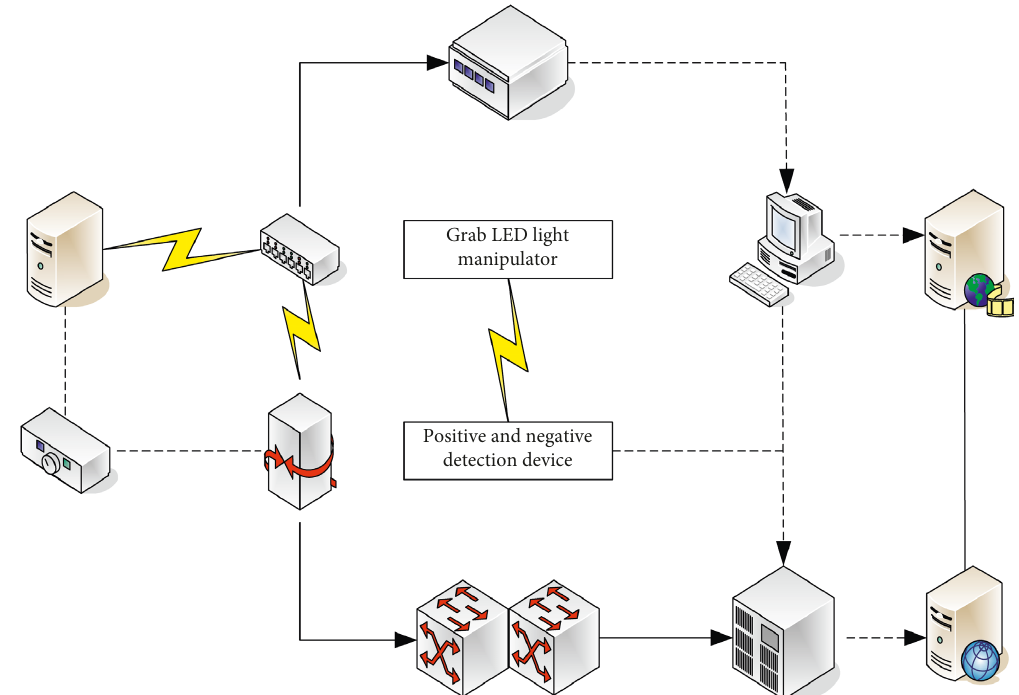
Figure 2: The framework of the color spotlight control system on the